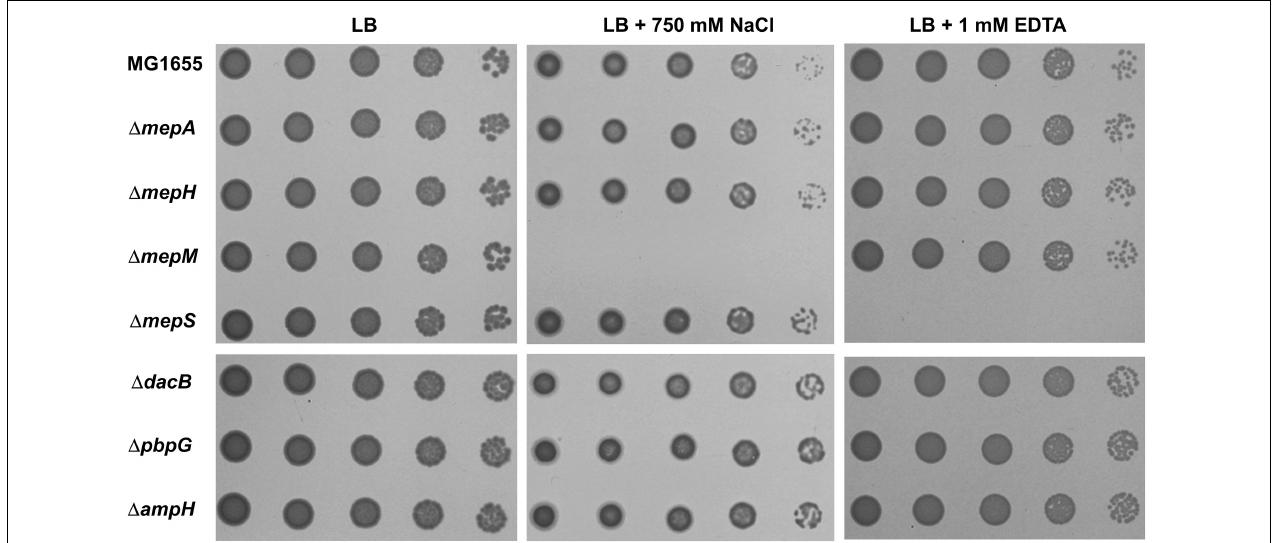
FIGURE 1 | Distinct phenotypes of PG endopeptidase mutants. The wild-type and PG endopeptidase mutant cells were serially diluted from 10 8 to 10 4 cells/mL in 10-fold steps and spotted onto an LB plate or LB plates containing 750 mM NaCl or 1 mM EDTA as indicated.